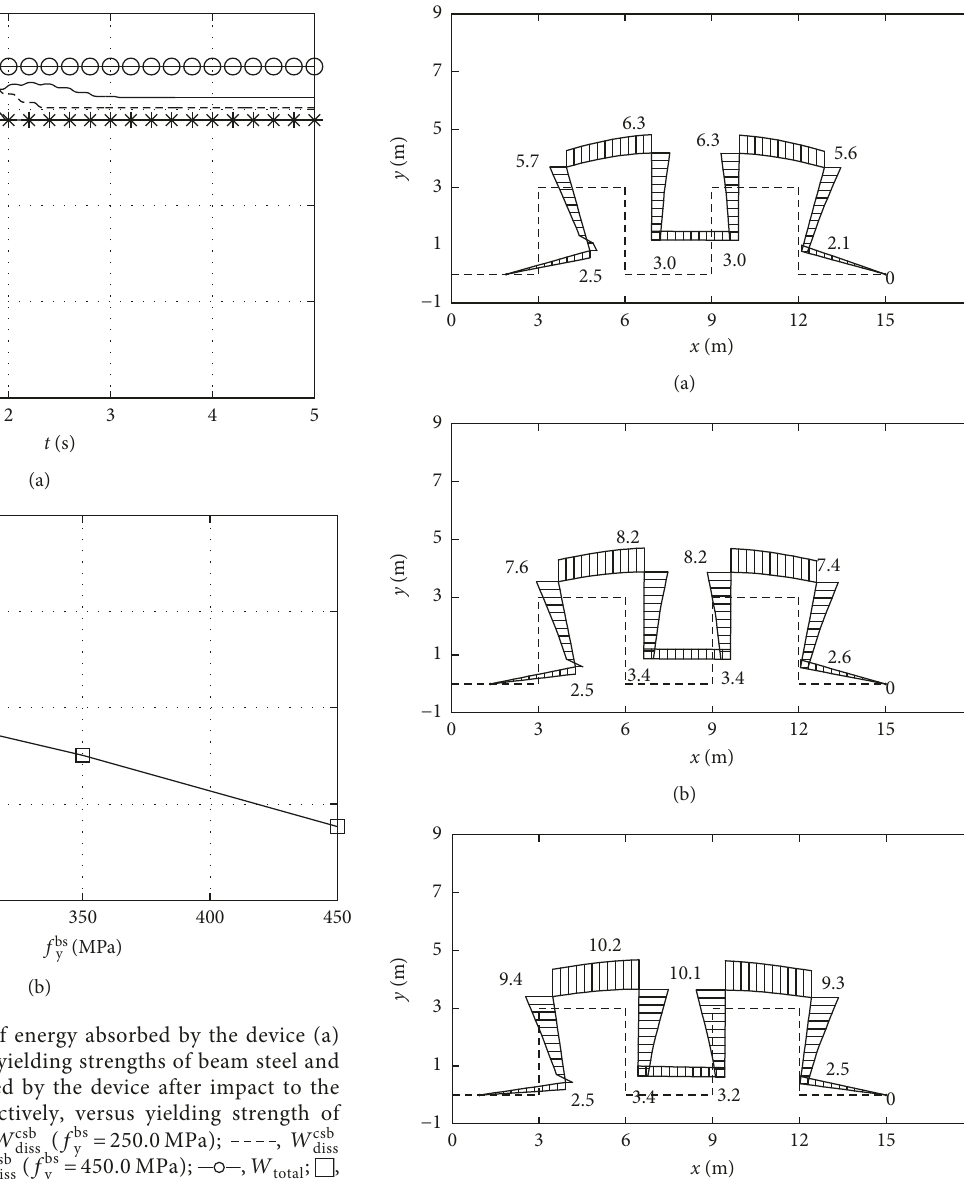
Figure 12: Maximum bending moment diagrams of the structures during impact and deflections of the structures after impact cor- responding to different yielding strengths of beam steel (unit: